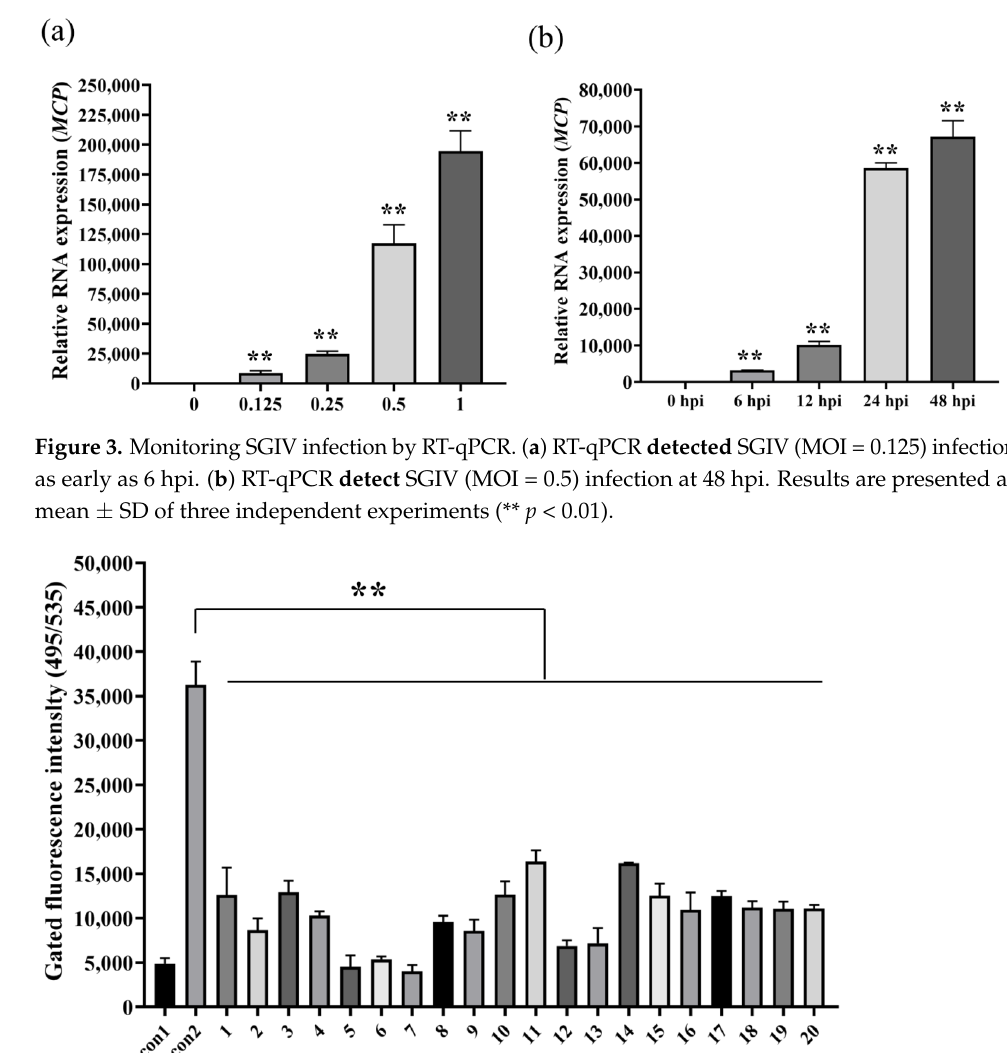
Figure 3 . Monitoring SGIV infection by RT-qPCR. ( a ) RT-qPCR detected SGIV (MOI = 0.125) infec- tion as early as 6 hpi. ( b ) RT-qPCR detect SGIV (MOI = 0.5) infection at 48hpi. Results are presented as mean ± SD of three independent experiments (** p < 0.01).